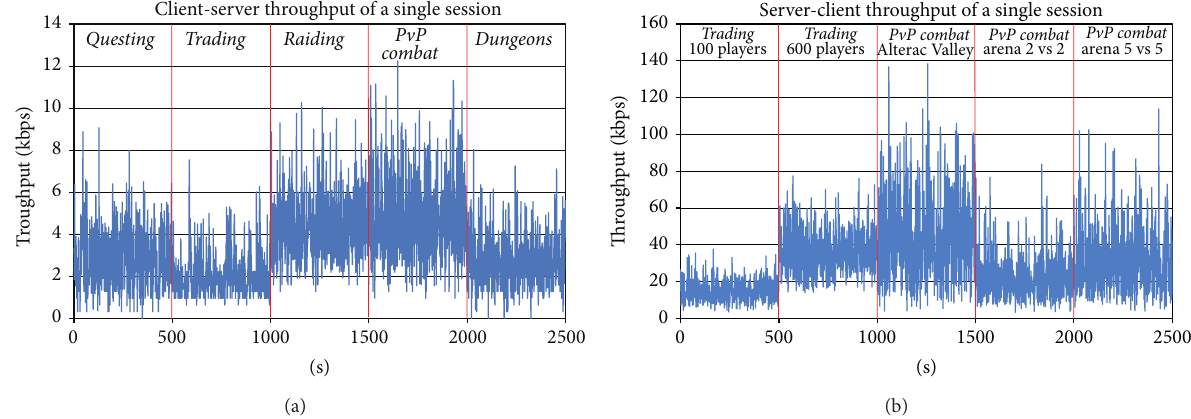
Figure 5: Throughput generated by the model for (a) client to server for each category and (b) server to client for Trading and PvP combat with different options.